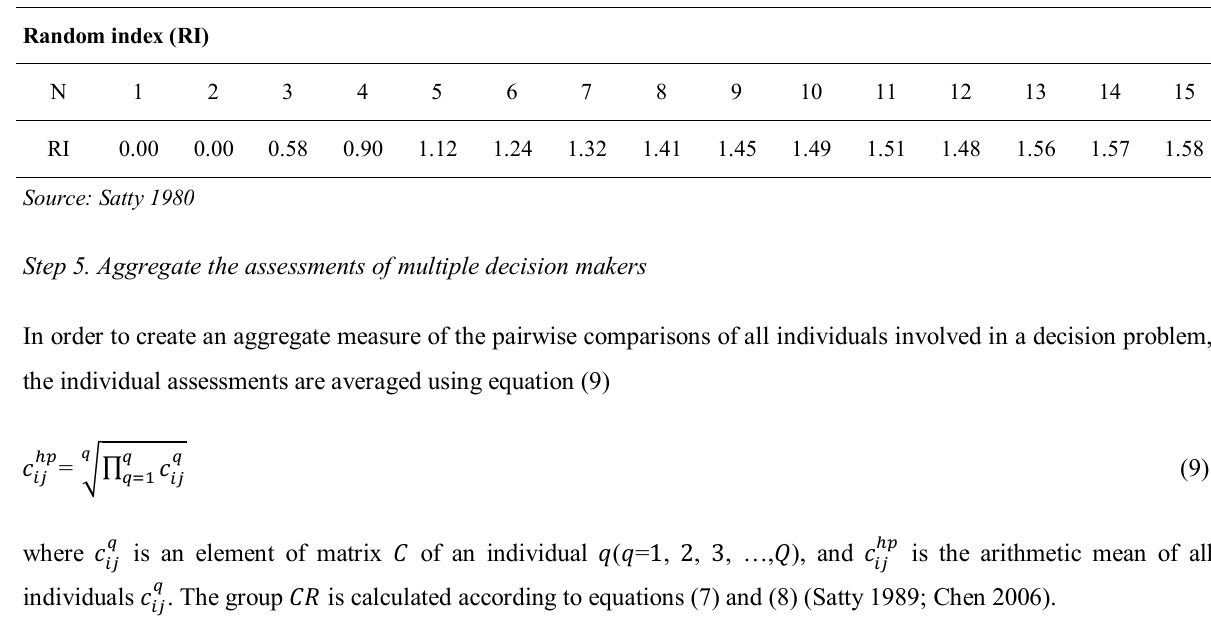
Table 2: Random index for